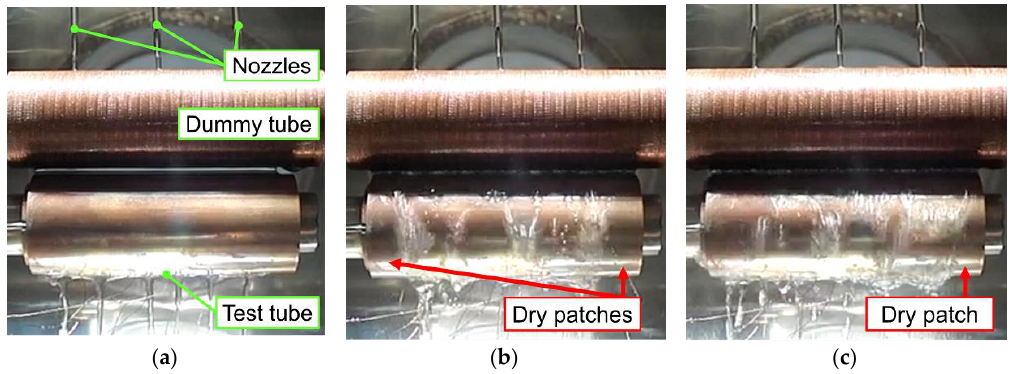
Figure 5. Falling film evaporation behaviors on the smooth tube. ( a ) Re f = 323 without heating. ( b ) Re f = 430, q = 33.4 kW·m −2 . ( c ) Re f = 643, q = 33.4 kW·m −2 . Figure 4. Heat transfer coefficients of falling film evaporation against the film Reynold’s number, Re f .